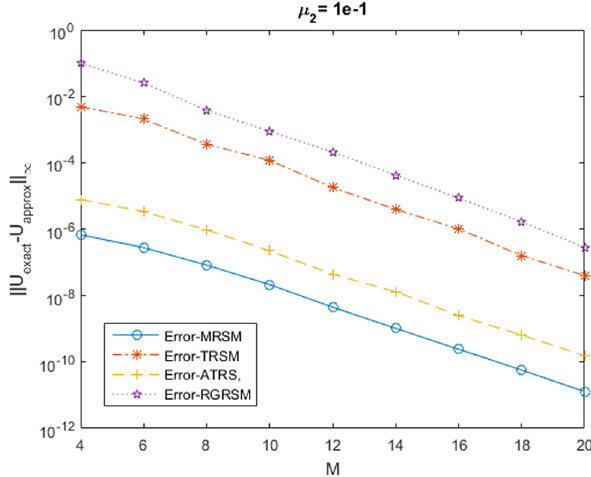
Figure 9: The absolute error of Example 4.2 by RSMs with t 0, 1 (